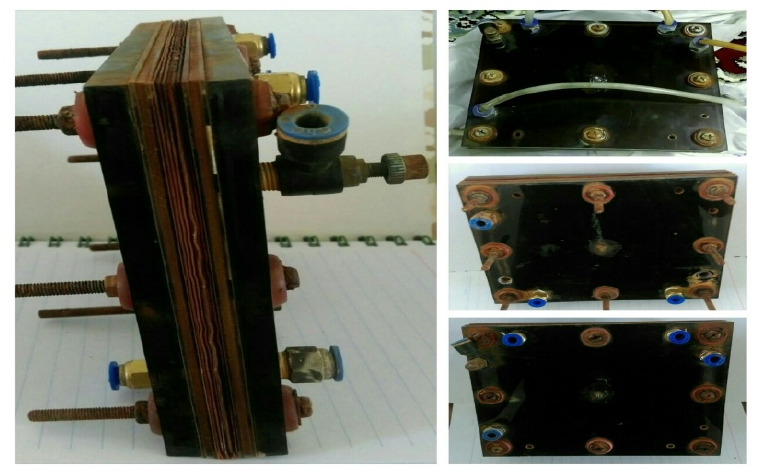
Fig. 1. Schematic diagram of ED